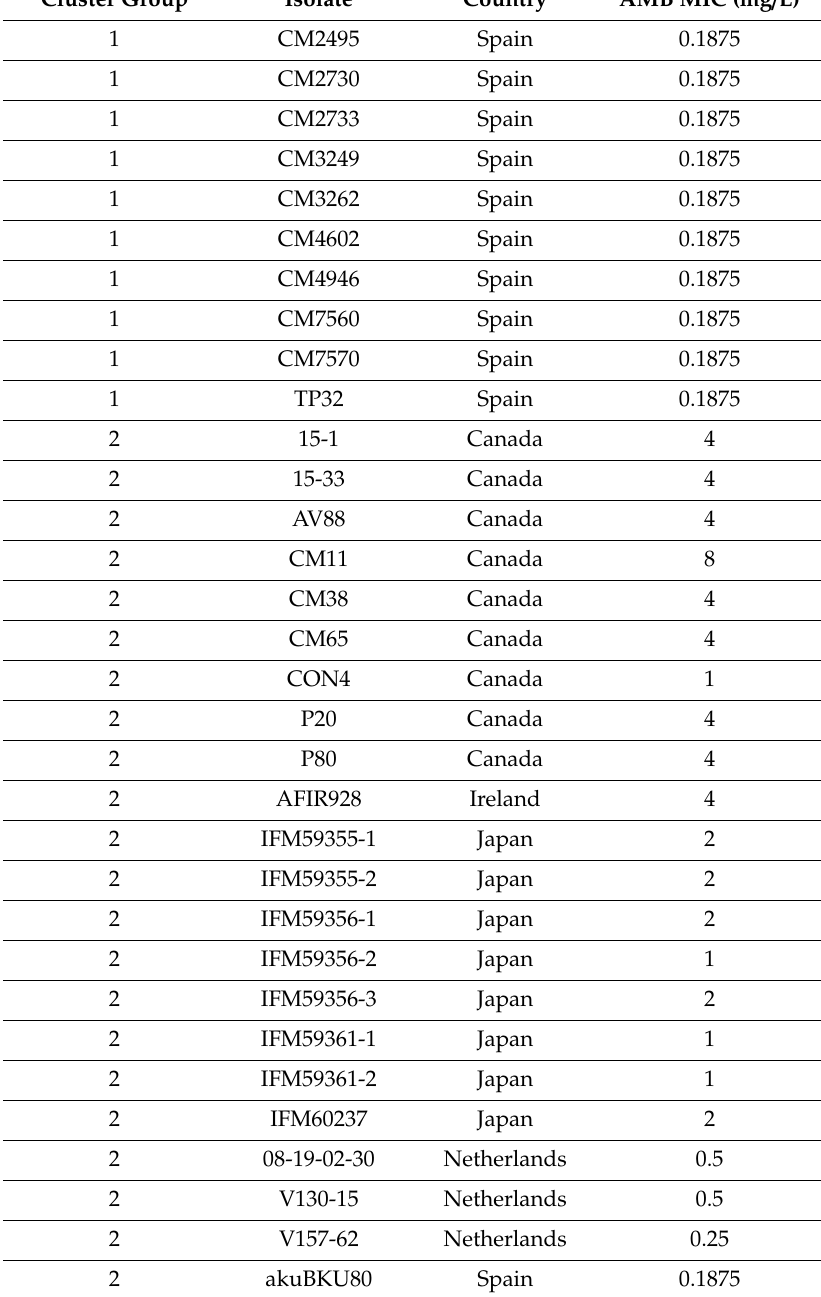
Table 3. K-means cluster analysis results for strains with AMB susceptibility data. Isolate names and their geographic origins for all 71 strains are also shown in this